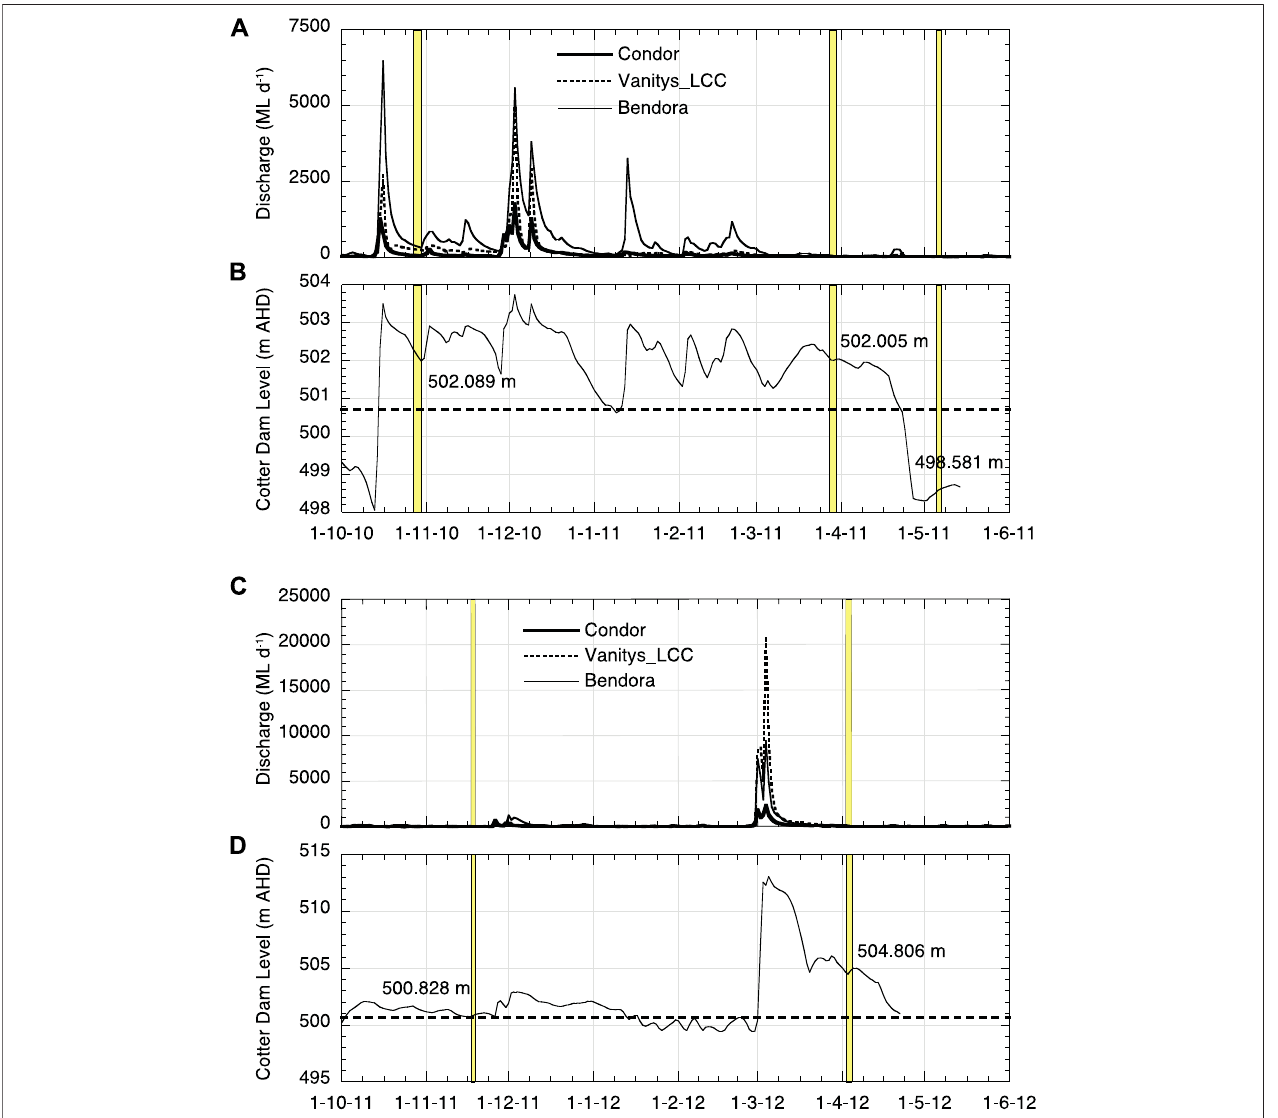
FIGURE3| Cotter Damdailyin fl owsandreservoirwaterlevelsduring (A,B) 2010 – 2011;and (C,D) 2011 – 2012.In fl owdataareforCondorCk(bold), LowerCotter Catchment at Vanitys Crossing (thin dashed line), and Cotter River below Bendora Dam (thin solid line). Discharge from the Lower Cotter Catchment was calculated as the gauged fl ow at Vanitys Crossing less the discharge from Bendora Dam. Heavy dashed line denotes crest of old dam. Yellow bars denote fi eld trips and the correspondingwater levels areshown asm AHD. Sourcedata courtesy Dylan Evans,ALS, and Bureau ofMeteorology << http://www.bom.gov.au/waterdata/ >> .